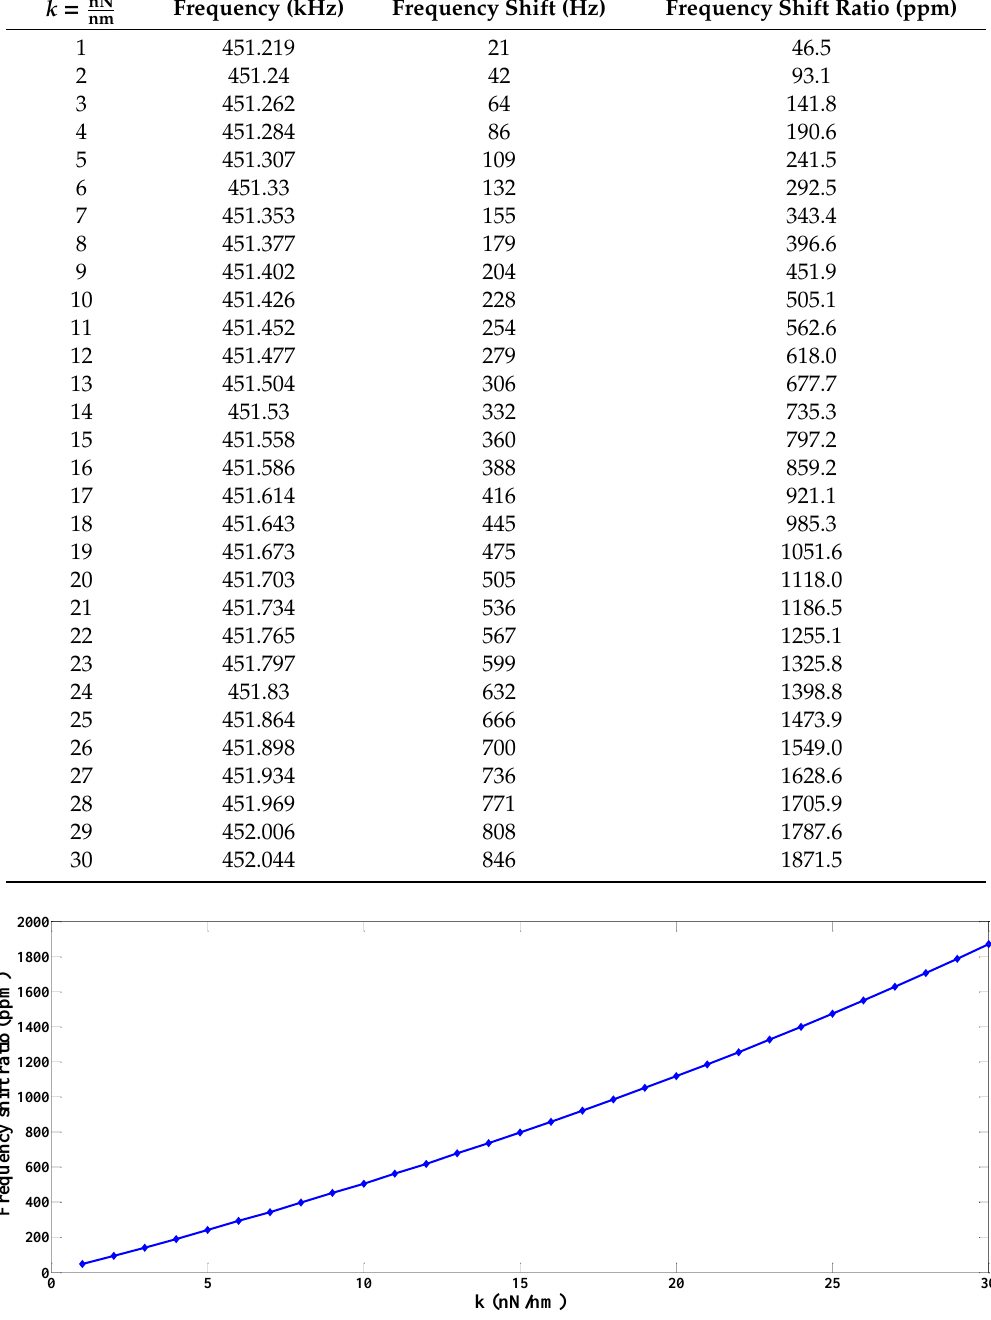
Table 1. Spring constants and natural frequencies of the first anti-phase mode and frequency shift.